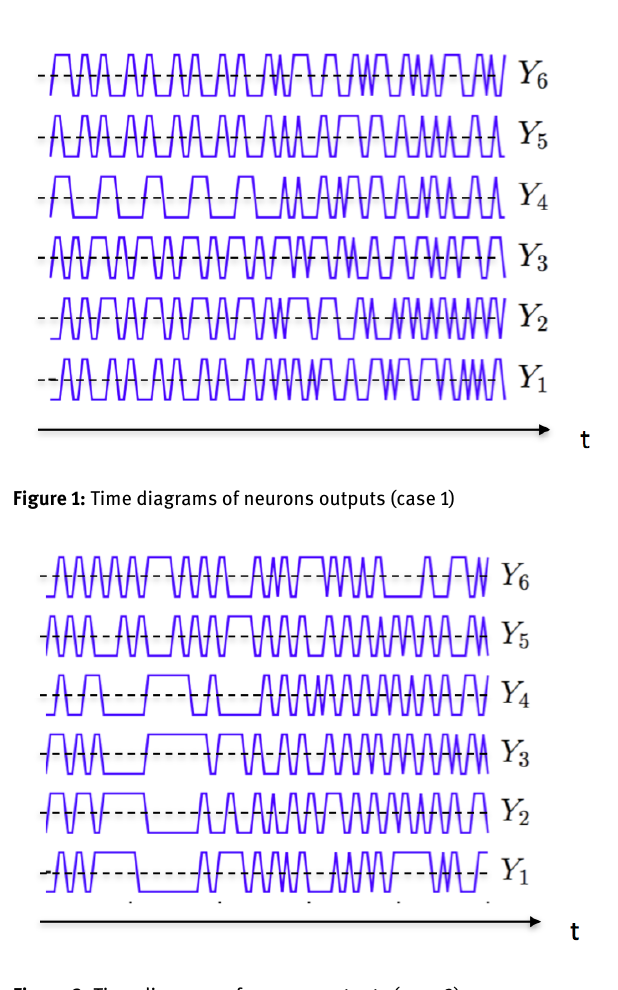
Figure 4: Scheme of invertor, which corresponds to equation